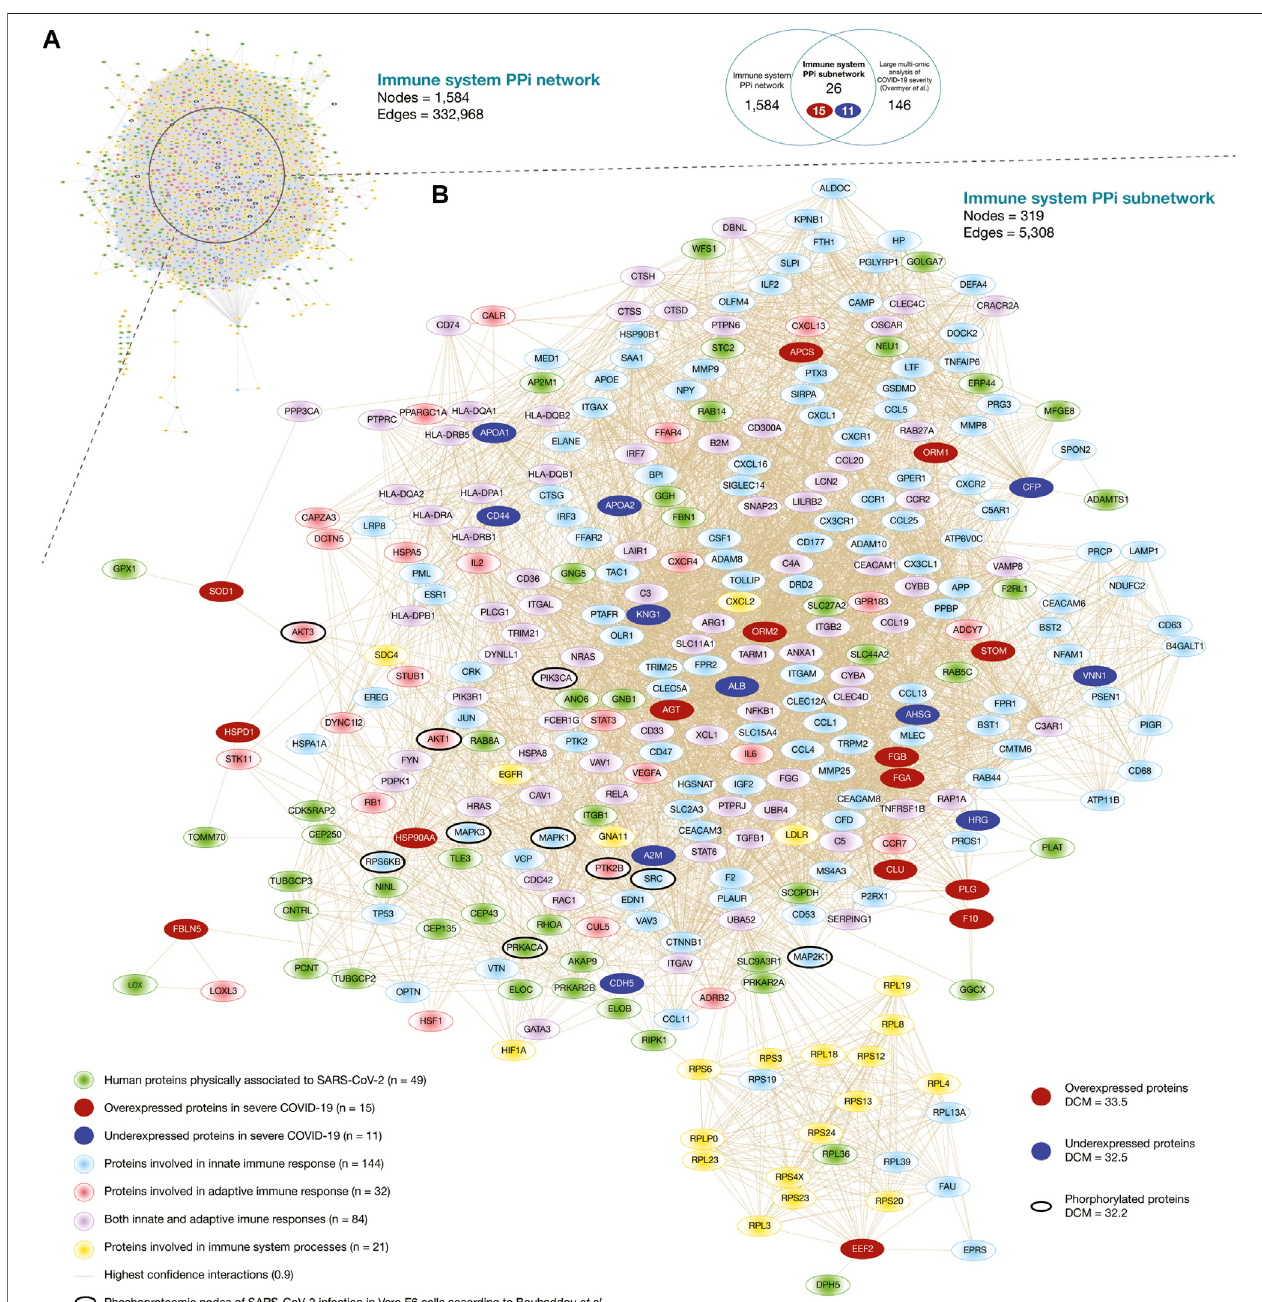
FIGURE 2 | Immune system protein interactomes. (A) Immune system PPi network. (B) Immune system PPi subnetwork made up of human proteins physically associated with SARS-CoV-2 proteins, immune system proteins, signi fi cantly expressed proteins in severe COVID-19, and signi fi cantly expressed proteins of SARS- CoV-2 infection in Vero E6 cells. DCM: degree centrality